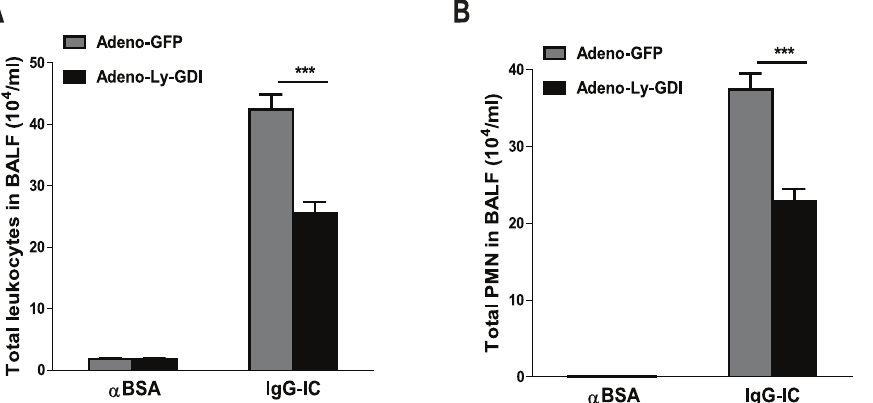
Fig 4. Over-expression of Ly-GDI reduces IgG immune complex-stimulated leukocytes accumulation in alveoli. Adeno-GFP or Adeno-Ly-GDI was injected to mice via an airway instillation at a dose of 5 × 10 8 PFU. 3 days later, the mice were subjected to IgG immune complex-induced lung injury or control treatment ( α BSA only). Total leukocytes (A) and neutrophils (B) in BAL fluids were counted 4 h later. Data were expressed as means ± S. E. M. N (cid:1) 3 mice for each group. *** indicated statistically significant difference- p <